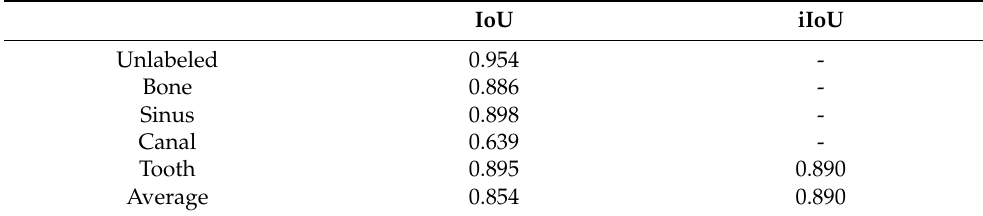
Table 3. Intersection over union (IoU) and instance-level IoU (iIoU) for each category.